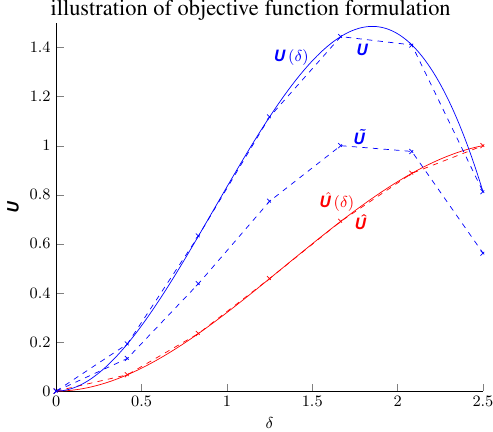
Figure 1. Illustration of energy-paths for objective function. ˆ U ( δ ) ≈ ˆ U is the target behaviour, U ( δ ) ≈ U is the actual obtained behaviour and e U is the actual obtained behaviour normalized for an amplitude-independent